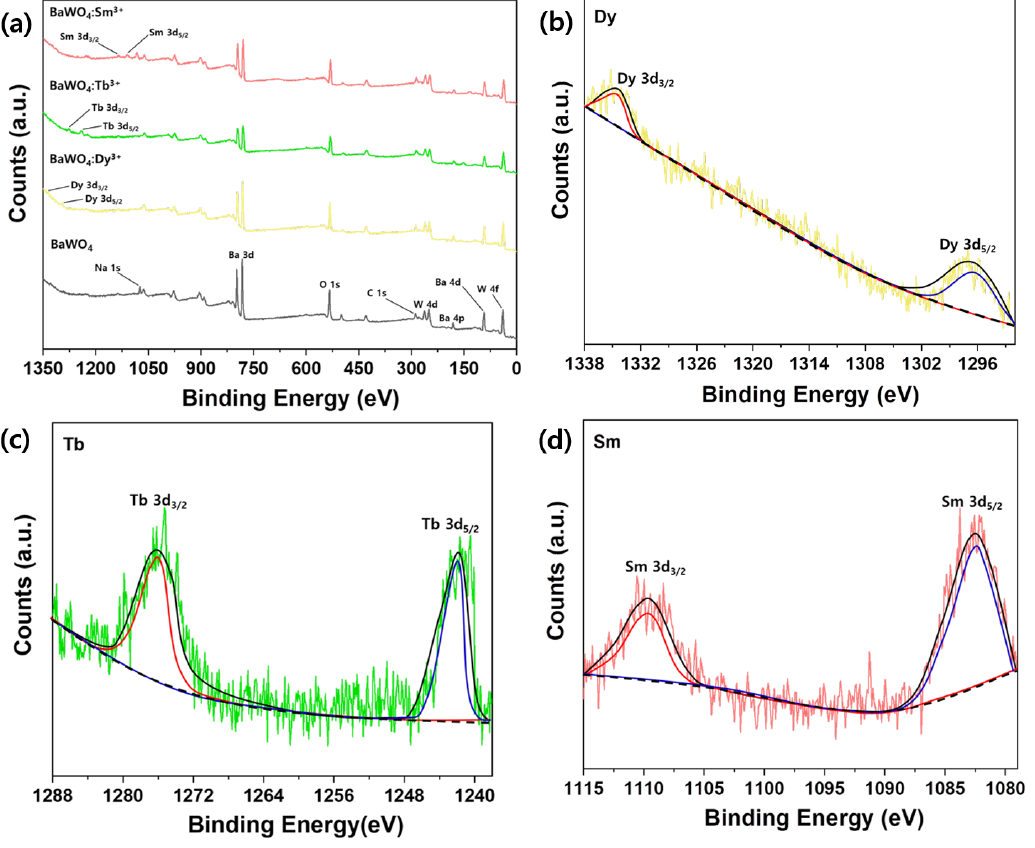
Figure 6. XPS spectra; ( a ) survey scan of un-doped BaWO 4 powders and RE 3 + -doped BaWO 4 phosphors, ( b ) scan of Dy 3 + 3d states, ( c ) scan of Tb 3 + 3d states, ( d ) scan of Sm 3 + 3d states.